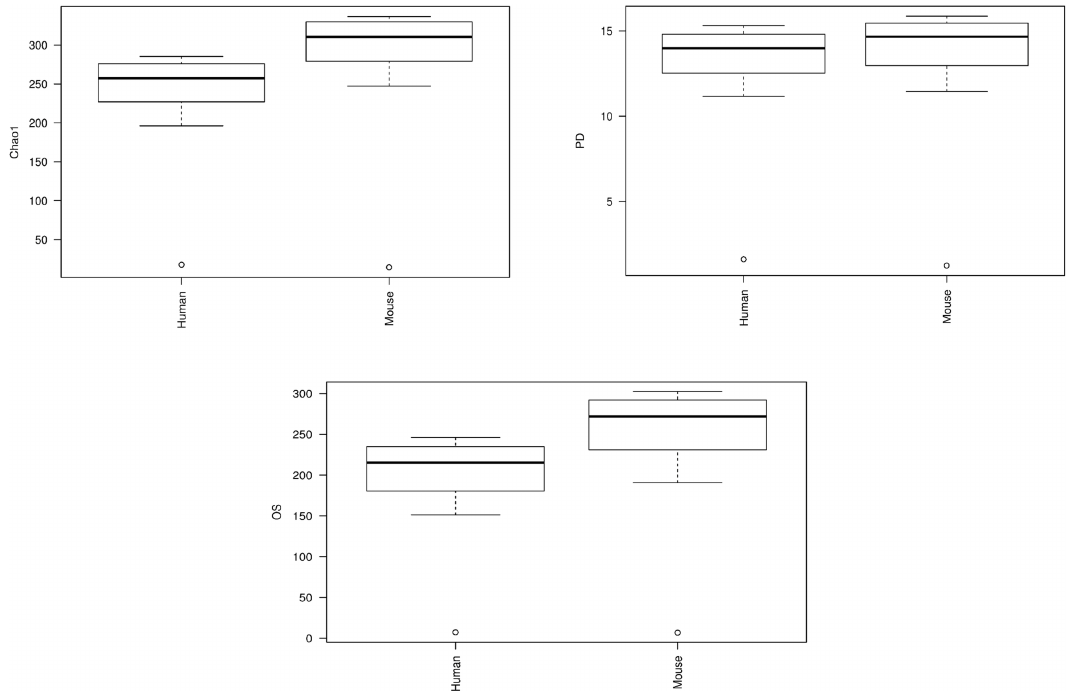
Fig 3. Humanization of mice. Alpha diversity representedin the form of box plots show similar richness and evennessin humanizedmice and humandonors four weeks after humanization of the mice using FMT. The phylogeneticdiversity (PD) evaluatesthe length of all branches of the phylogenetictree of a given population. Chao1 estimates the total species richness and observedspecies (OS) counts the uniqueOTU’s. The median,the first quartileand third quartilevalues in humans resemblethat of mice. Whiskers in the boxplot representthe range of minimum and maximum alpha diversity values within a population,excludingoutliers. The range of values for humanand mice are similar. These results indicate that the summary statistics (measures of central tendencies) of humanand mice data are alike further enforcing the fact that the humanization of mice was successful.